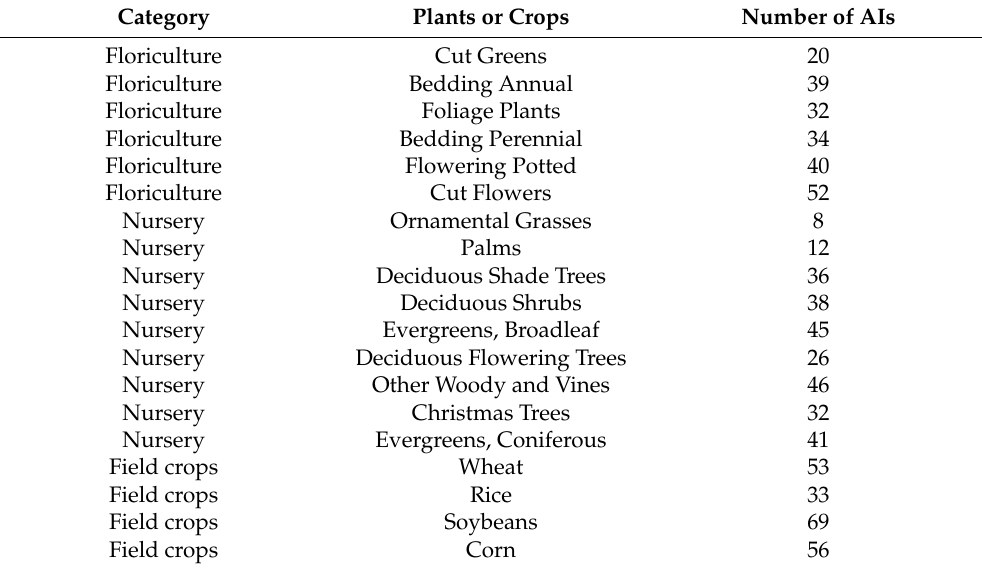
Table 1. Essential details from the AIs database for plants or